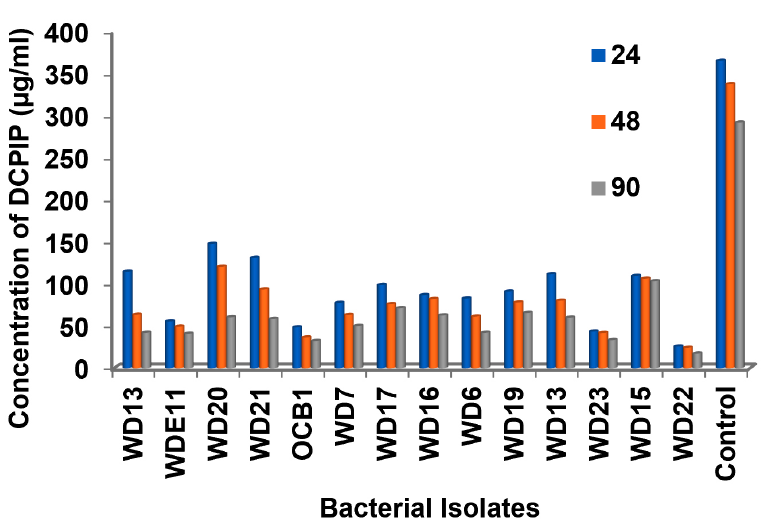
Fig. 3. Reduction in DCPIP concentration due to bacterial degradation of